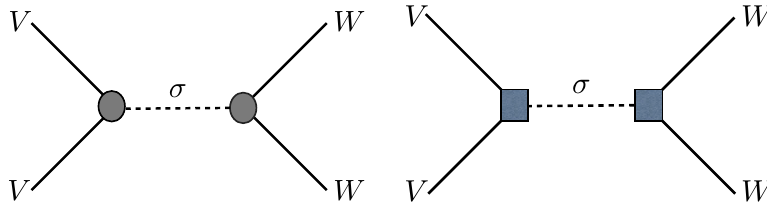
Figure 3 . At leading order in large correlation functions are controlled by exchange of hydrody- N namic (cid:12)elds (cid:27) ( t ). The only di(cid:11)erence between time ordered (left) and out-of time-ordered (right) con(cid:12)gurations is in the e(cid:11)ective vertex describing the coupling to (cid:27) ( t